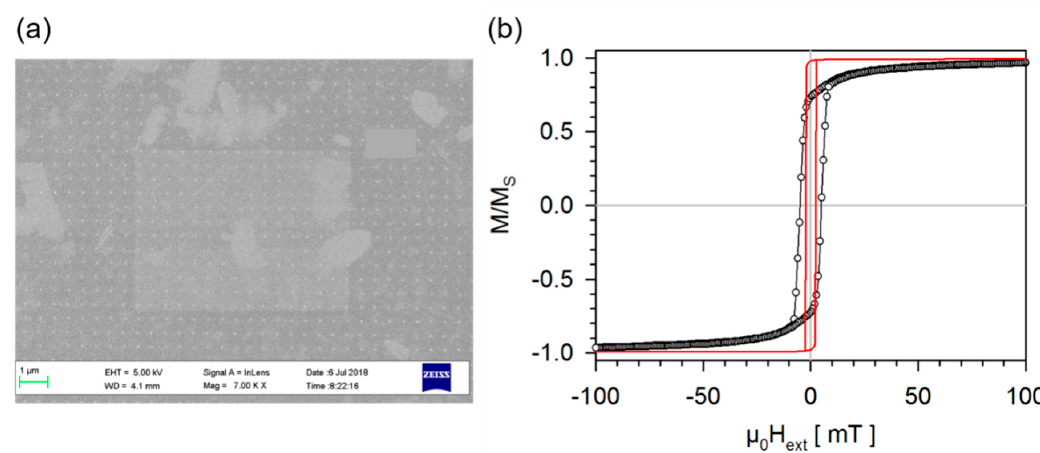
Figure 7. In-plane magnetization reversal of an array of Co 2 MnSi Heusler nano-cylinders. ( a ) REM image of an array of Co 2 MnSi Heusler nano-cylinders during preparation at a stage before the Ar+- ion beam milling is performed. Thus, the Co 2 MnSi Heusler nano-cylinders are capped with Ta. The mean diameter of the nano-cylinders are (46.5 ± 2.7) nm, their height should be 45 nm. ( b ) In black the normalized magnetization of these particles measured by utilizing an alternating gradient magnetometer. In red a micromagnetic calculation of one Co 2 MnSi Heusler nano-cylinder employing the quasistatic micromagnetic simulation package MicroMagus version 7.1. The magnetic parameters are taken from Figure 1. The closest match with the experimental data is found when using a cylinder height of 43.5 nm for these simulations.